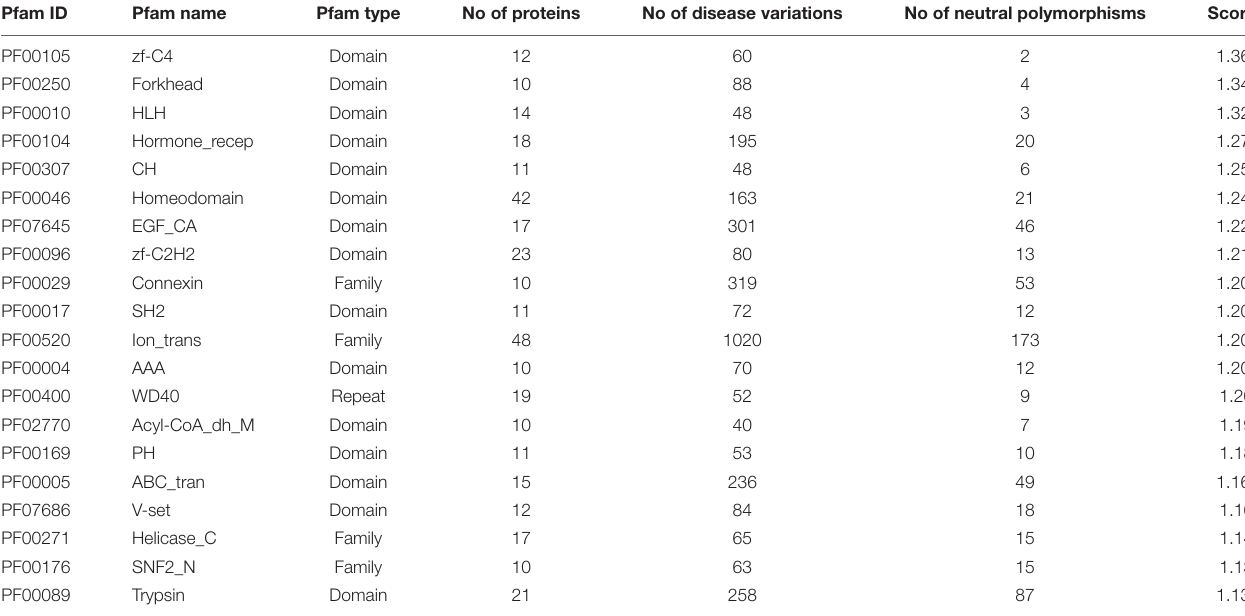
TABLE 2 | The 20 highest scoring Pfam entries mostly associated with